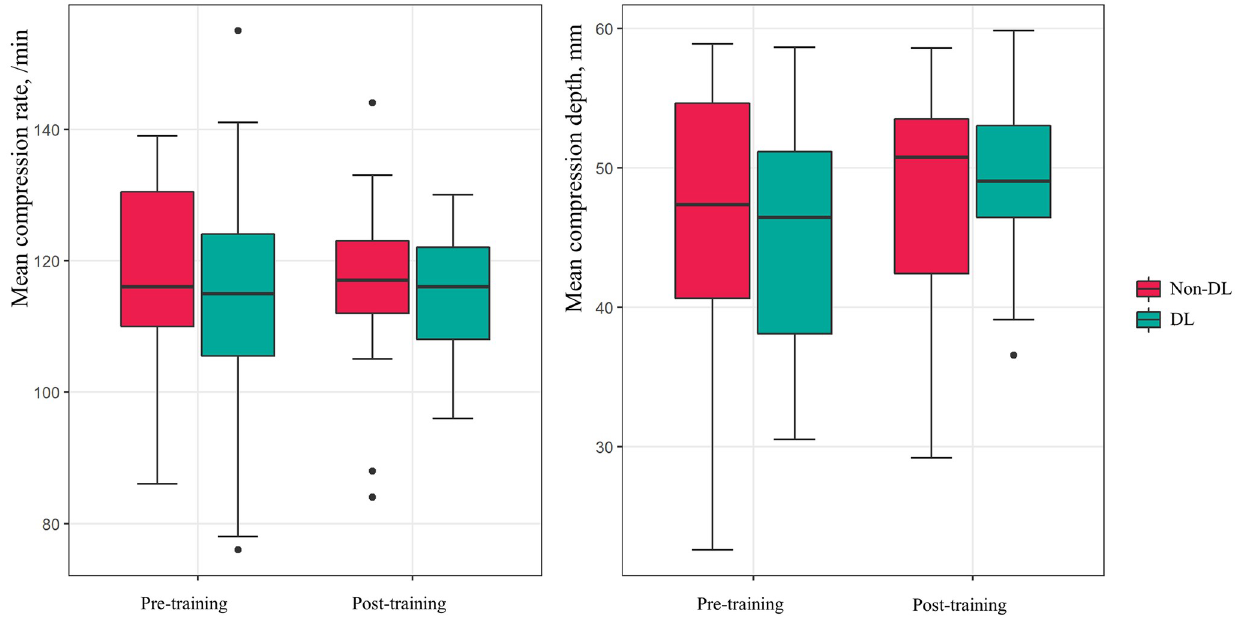
Fig 4. Pre- and post-training mean compression rates and mean compression depths from the non-DL and DL groups. DL, distance